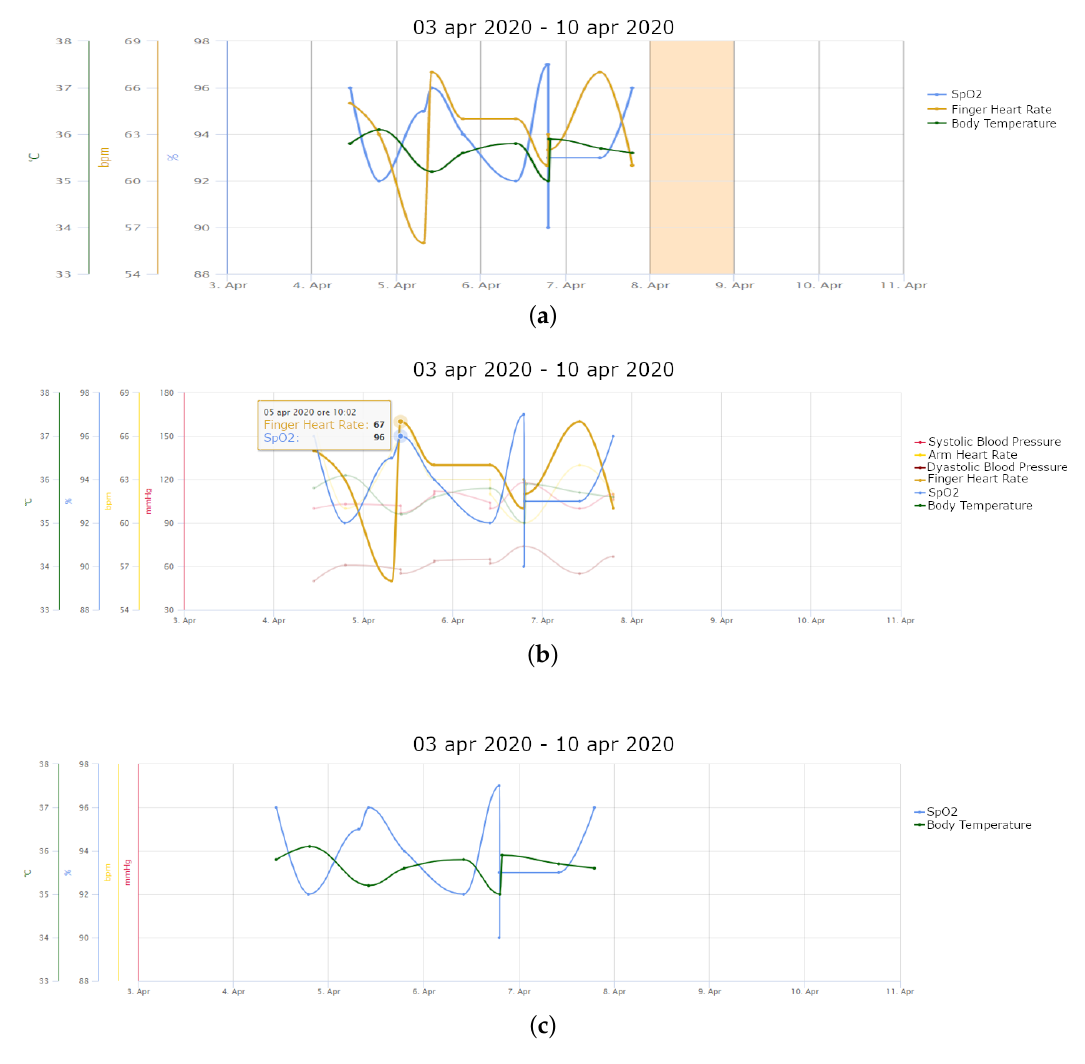
Figure 2. Trend of measurements of a patient aged 71 years with atrial fibrillation: ( a ) SpO 2 , finger HR and body temperature; ( b ) evidence of a measurement of SpO 2 and finger HR; ( c ) highlighting of SpO 2 and body